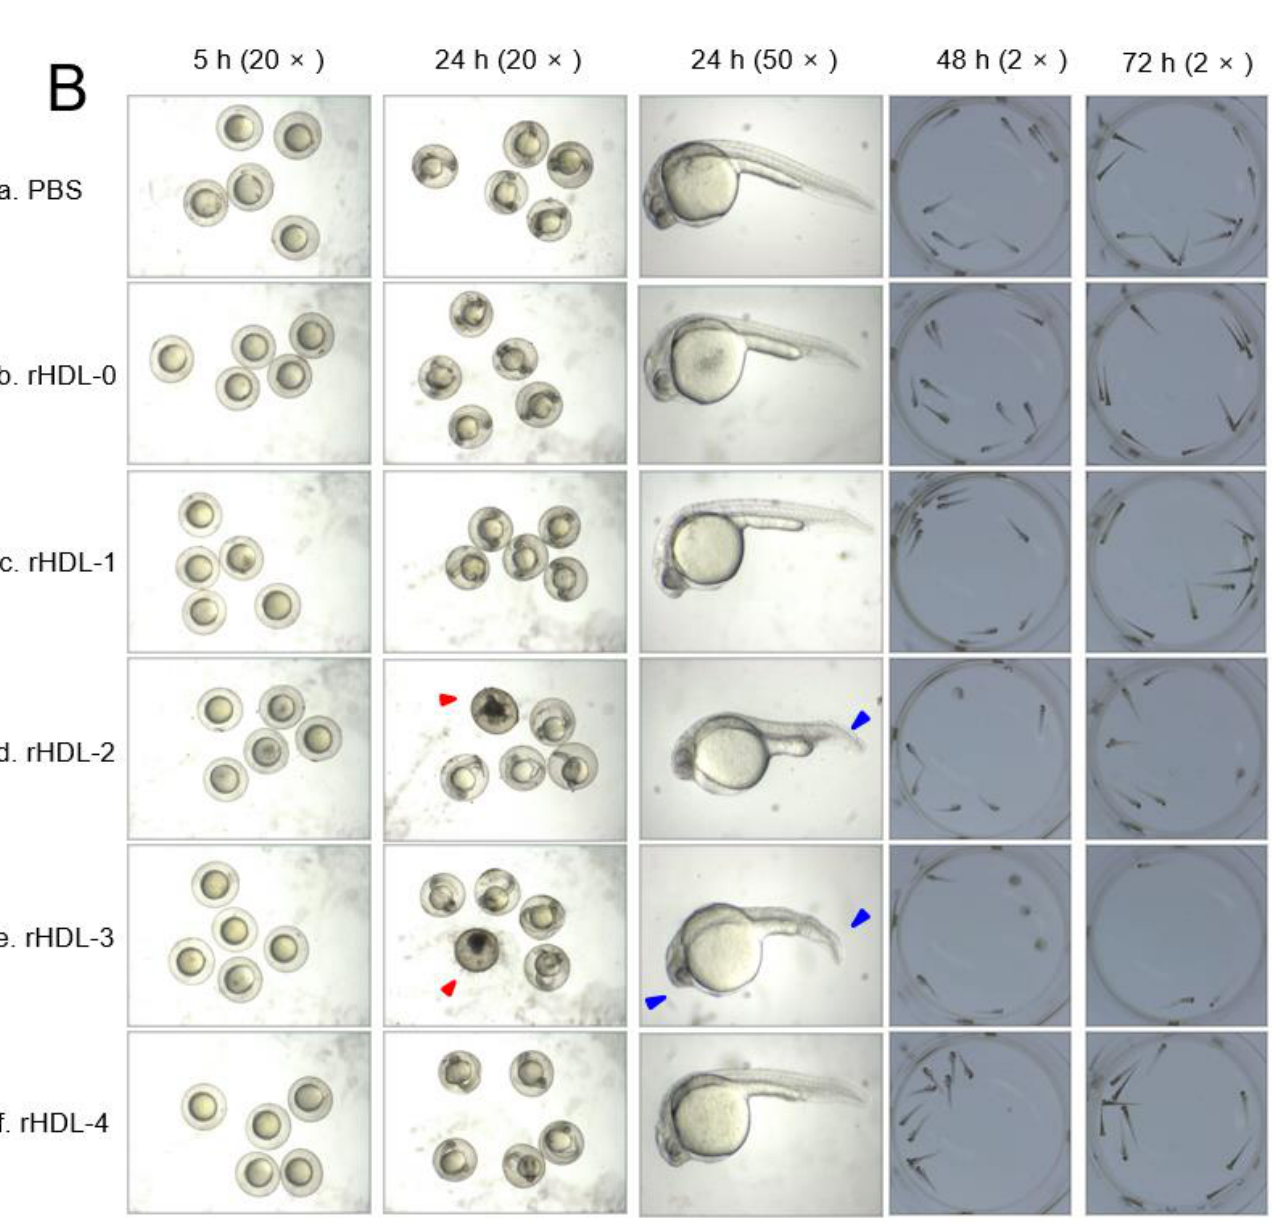
Figure 5. Embryo survivability and developmental morphology after the injection of rHDL contain- ing around 16 ng of apoA-I and 250 pg of each policosanol. ( A ) Survivability of zebrafish embryo during 24 h post-injection of each rHDL. *, p < 0.05 versus PBS alone; **, p < 0.01 versus PBS alone; ns, not significant versus PBS alone. Embryo numbers were adjusted from three independent exper- iments. Statistical differences of multiple groups were compared using a one-way analysis of vari- ance (ANOVA). ( B ) Developmental morphology of the embryos at 5 h, 24 h, 48 h, and 72 h post- injection. Red arrowheads indicate defective development and embryo death in the rHDL-3 group (photo e) at 24 h. The blue arrowhead indicates the slowest developmental speed in eye pigmenta- tion and tail elongation in the rHDL-3 group (photo e) at 24 h-post injection. a. PBS-alone injected; b. rHDL-0 injected; c. rHDL-1 injected; d. rHDL-2 injected; e. rHDL-3 injected; f. rHDL-4 in-